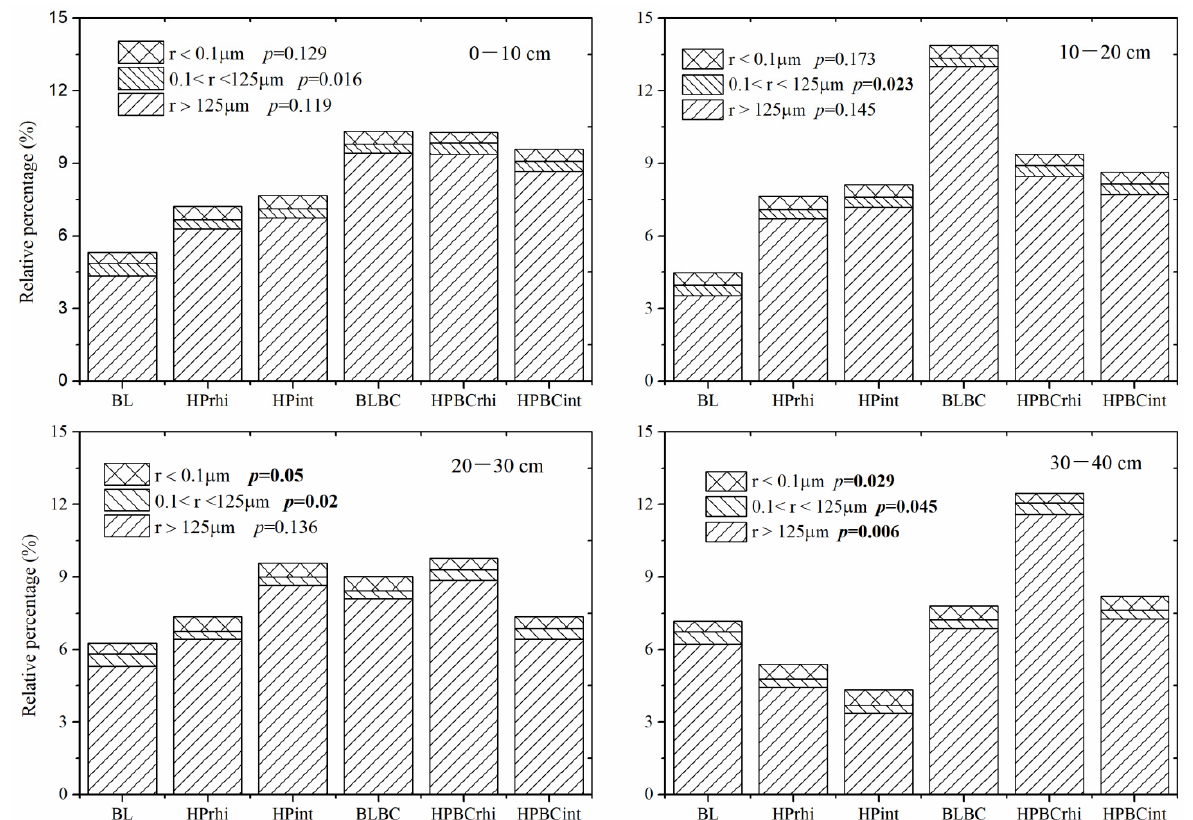
Figure 7. Relative percentages of three pore size groups calculated from SWRC for each soil layer in experimental plots. Note: BL—bare land treatment; HPrhi—planted location in honeysuckle planting treatment; HPint—inter-row location in honeysuckle planting treatment; BLBC—bare land with biochar; HPBCrhi—planted location in honeysuckle planting plus biochar addition plot; HPBCint—inter-row location in honeysuckle planting plus biochar addition plot.